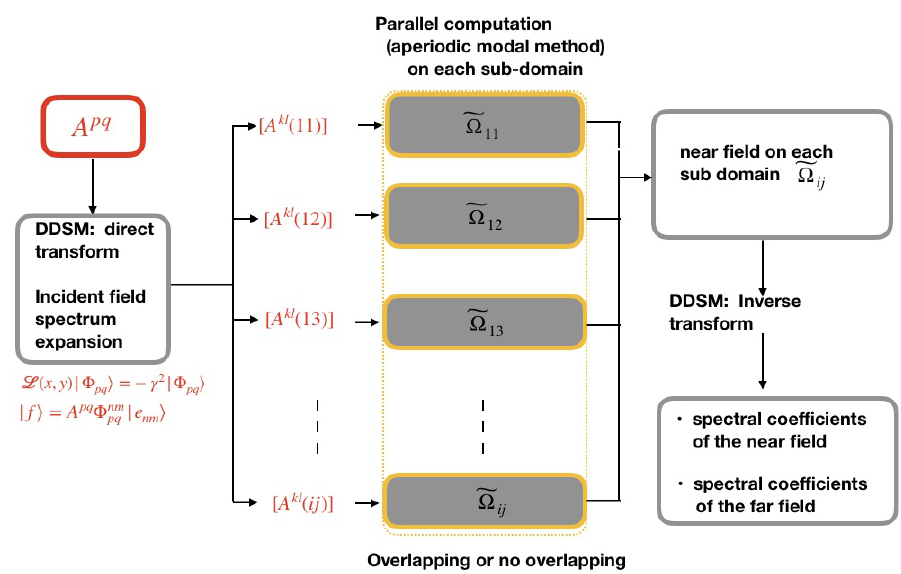
Figure 3. Flowchart and parallelization structure of the direct and inverse transform of DDSM applied to the near and far fields simulation of a photonics